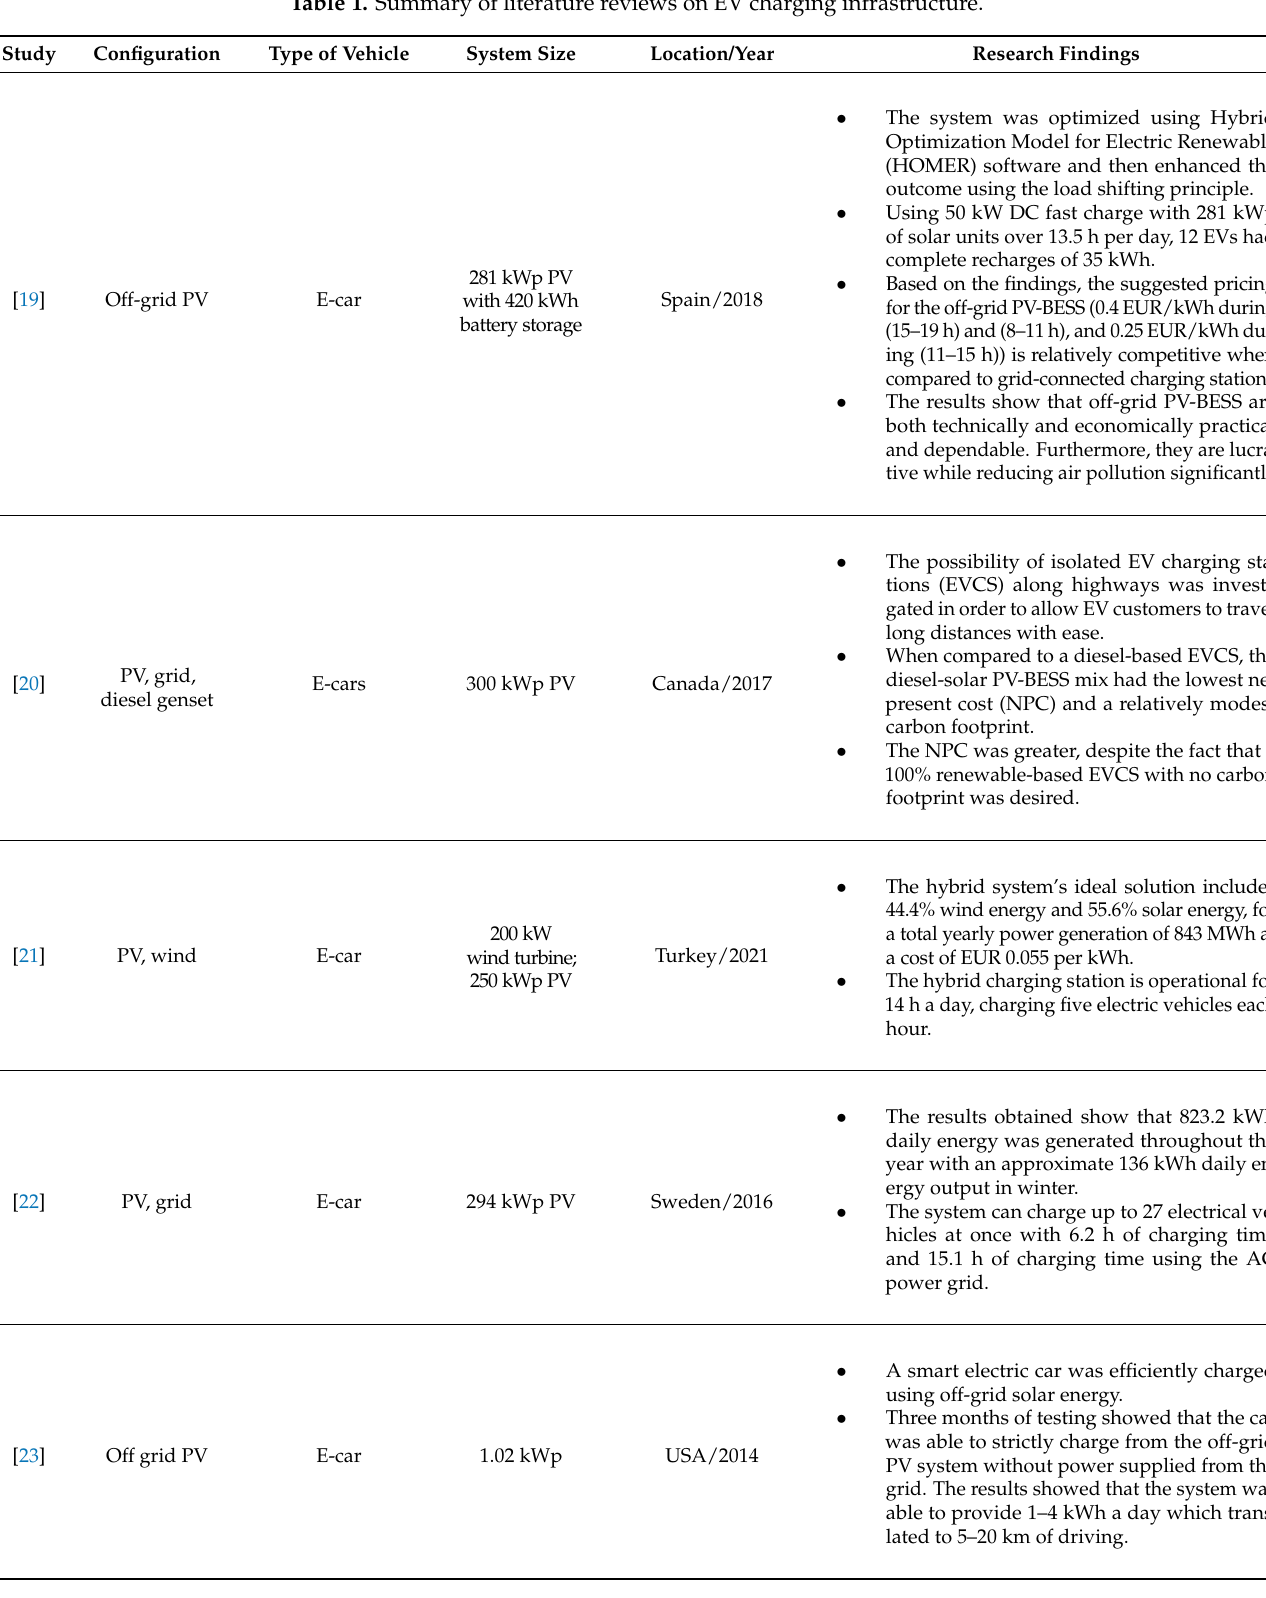
Table 1. Summary of literature reviews on EV charging